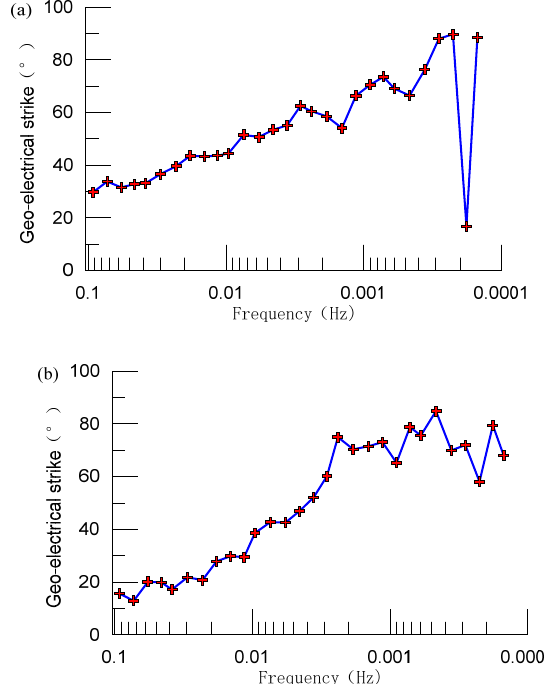
Figure 5. (a)The geo-electrical strike of the 2th LMT station with frequency;(b) The geo-electrical strike of the 6th LMT station with